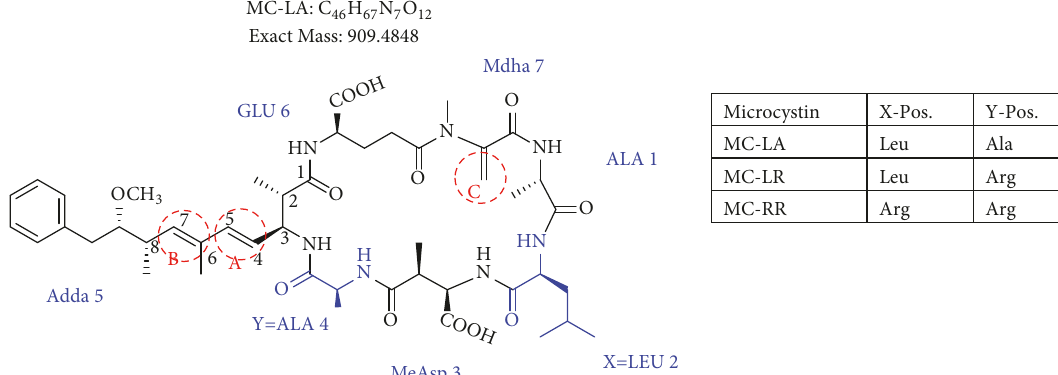
Figure 1: General structure of MC-LA showing variable amino acid positions and the primary (alkene) sites subject to permanganate oxida-